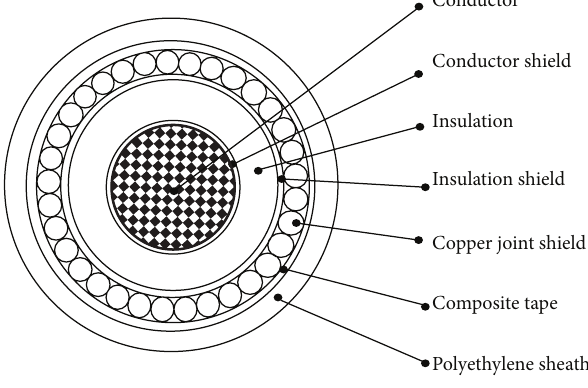
Figure 2: Structure of the